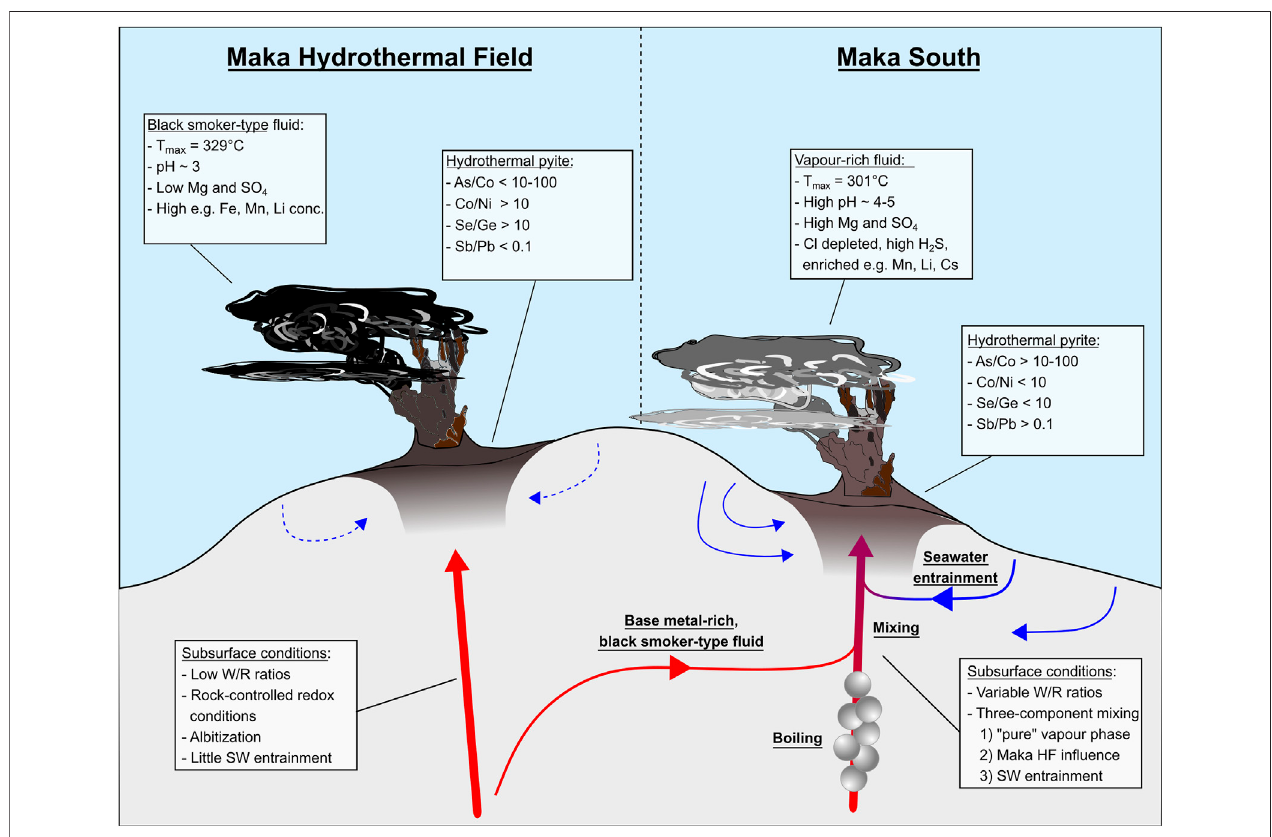
FIGURE 12 | Simpli fi ed hydrothermal model for the Maka HF and Maka South vent system summarizing the key hydrothermal processes based on the fl uid and sulphide data.